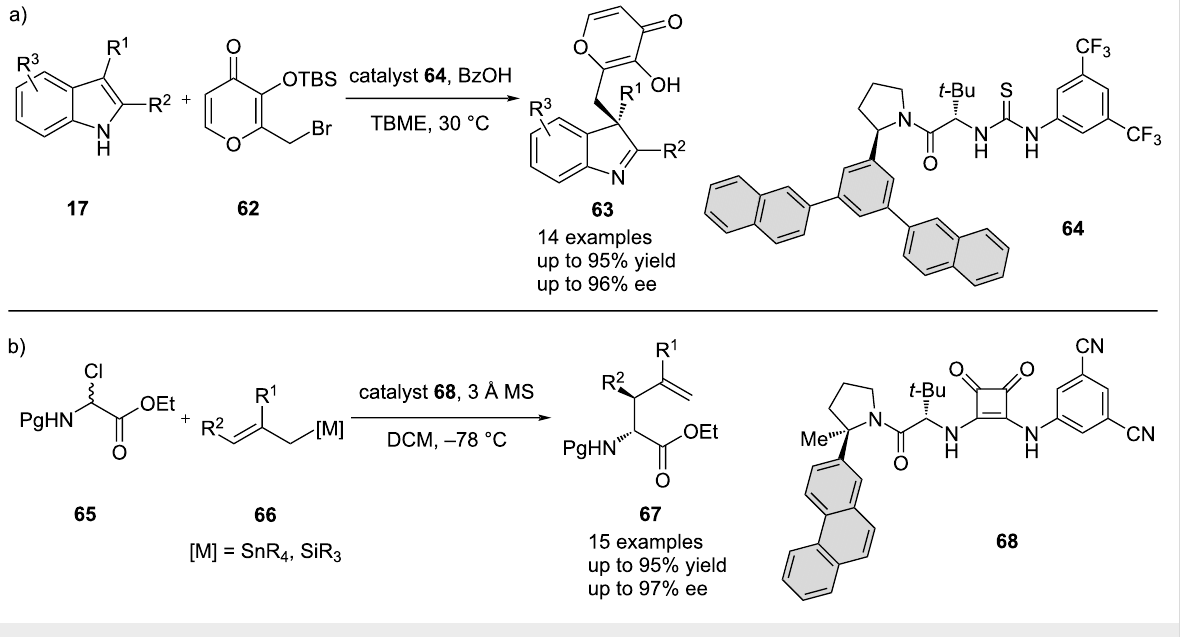
Scheme 14: Cation– π interactions in anion binding-catalyzed asymmetric addition reactions: a) addition of indoles to pyrones and b) allylation of α -chloro glycinates.